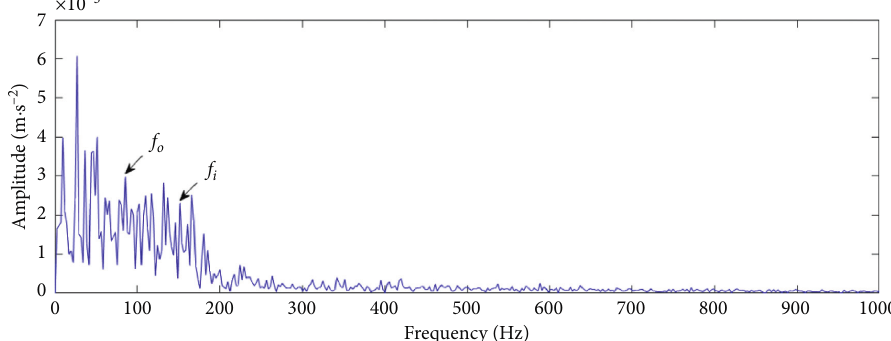
Figure 19: Envelope spectrum of sensitive IMF component by EMD